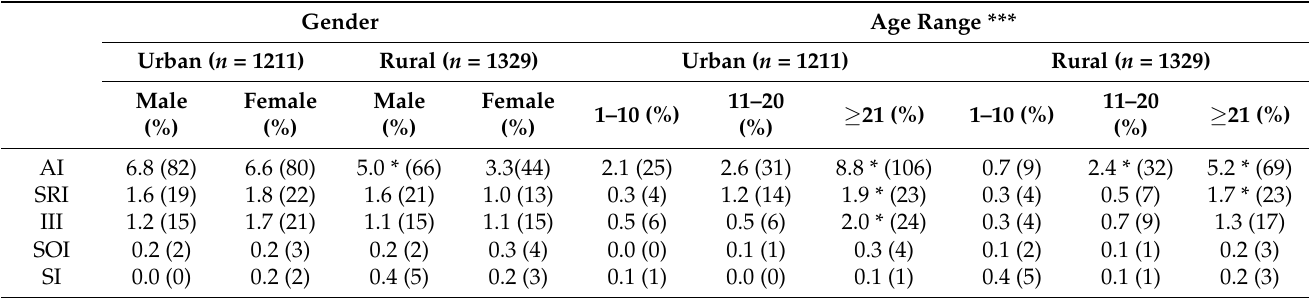
Table 3. Prevalence of clinical-immunological profiles of human L. ( L. ) infantum chagasi -infection by gender and age in distinct urban and rural scenarios in the Brazilian